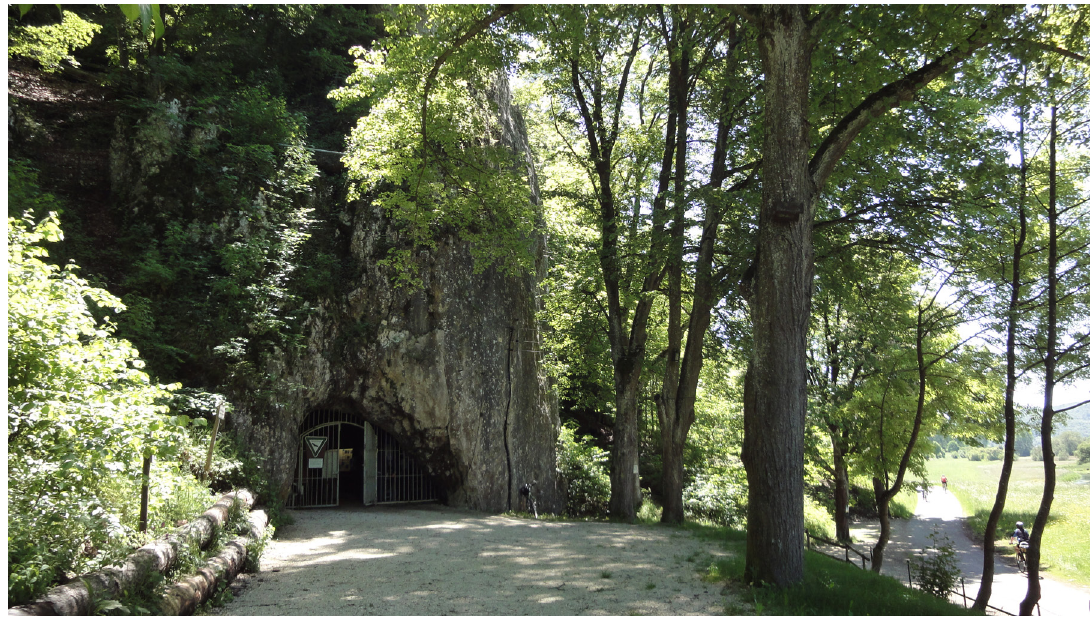
Figure 1. Hohle Fels Cave, entrance. Photo: E.